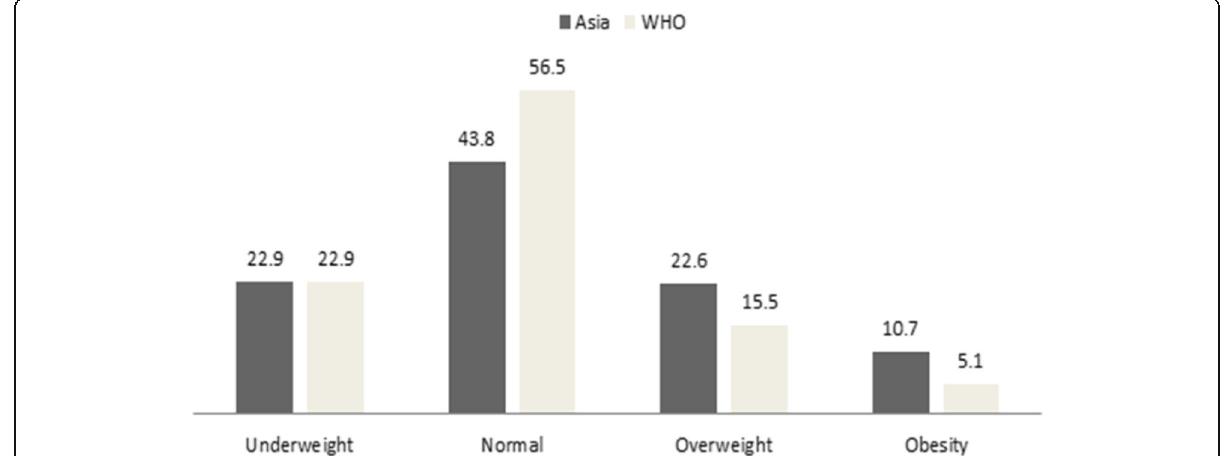
Fig. 1 Prevalence (%) of body weight categories according to Asian and World Health Organization cutoffs